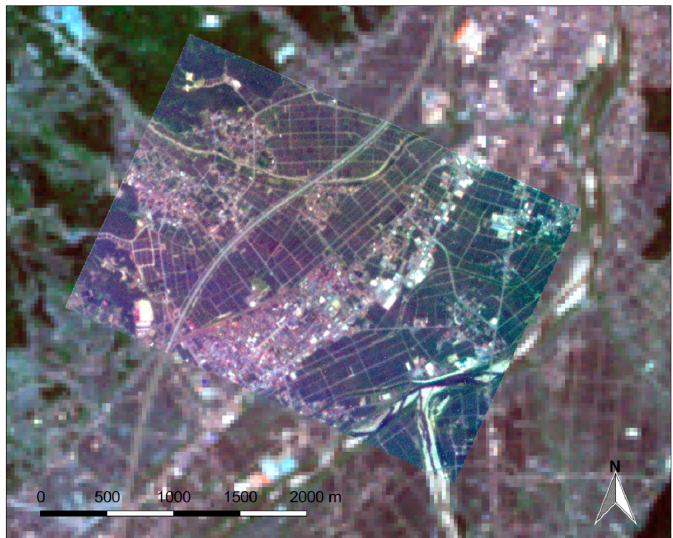
Figure 5. A true color composite image of Minami-Uonuma City, Niigata Prefecture, Japan, acquired by the RISING-2 HPT on 2 July 2014, overlaid on a true color composite image acquired by the Landsat 7 Enhanced Thematic Mapper Plus (ETM+) on 30 May 2014.